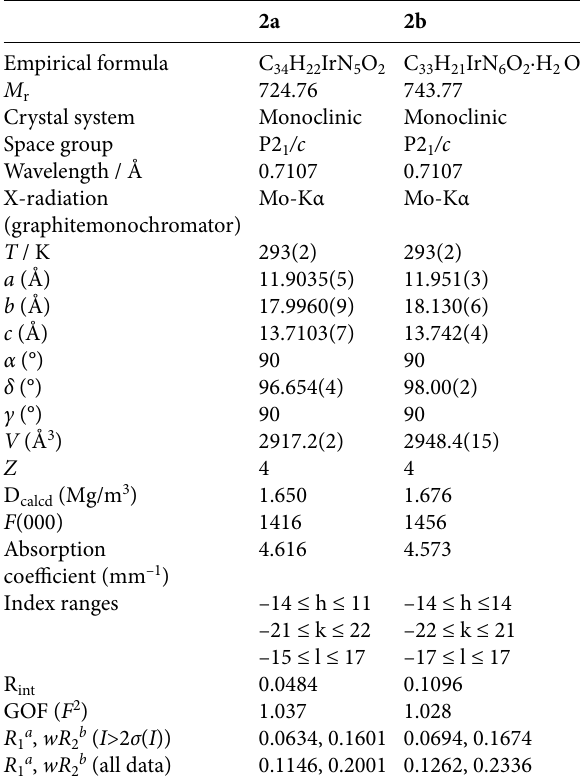
Table 1. Crystallographic data for complexes 2a – 2b